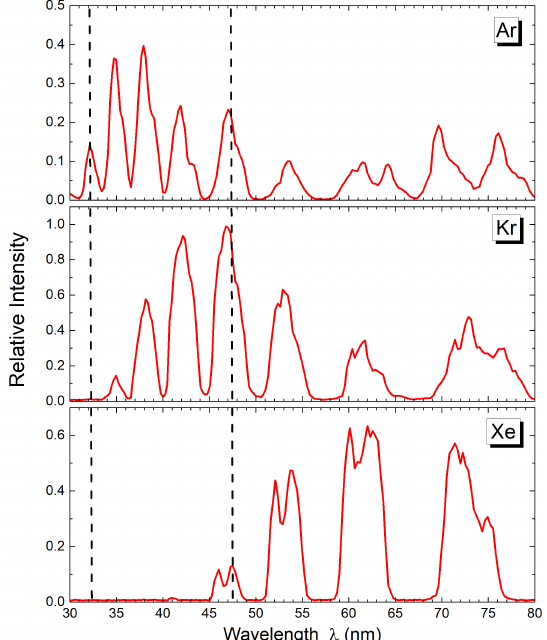
Figure 3. XUV spectra obtained for the Ar, Kr, and Xe HHG gases. All spectra were obtained at pressures of 70 Torr and identical laser focusing conditions. Dashed lines indicate the wavelengths of interest, corresponding to the two pairs of multilayer mirrors’ reflection narrowband